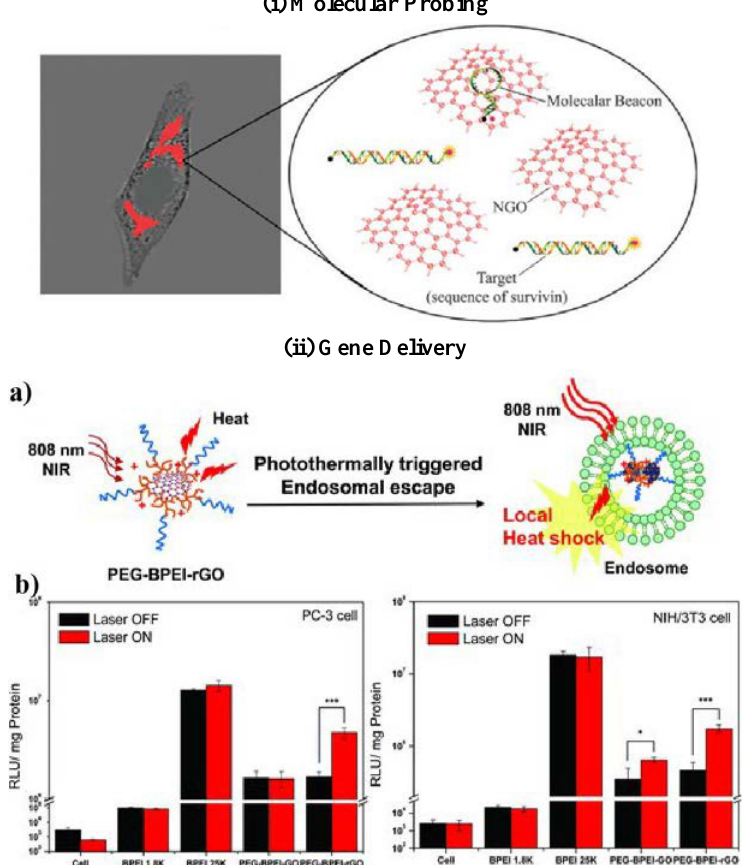
Fig. 3. Graphene-based nanomaterials for nucleic acid delivery. (i) Molecular probing. Schematic re- presentation of NGO delivery of MB into HeLa cells to detect survivin mRNA. Reproduced with